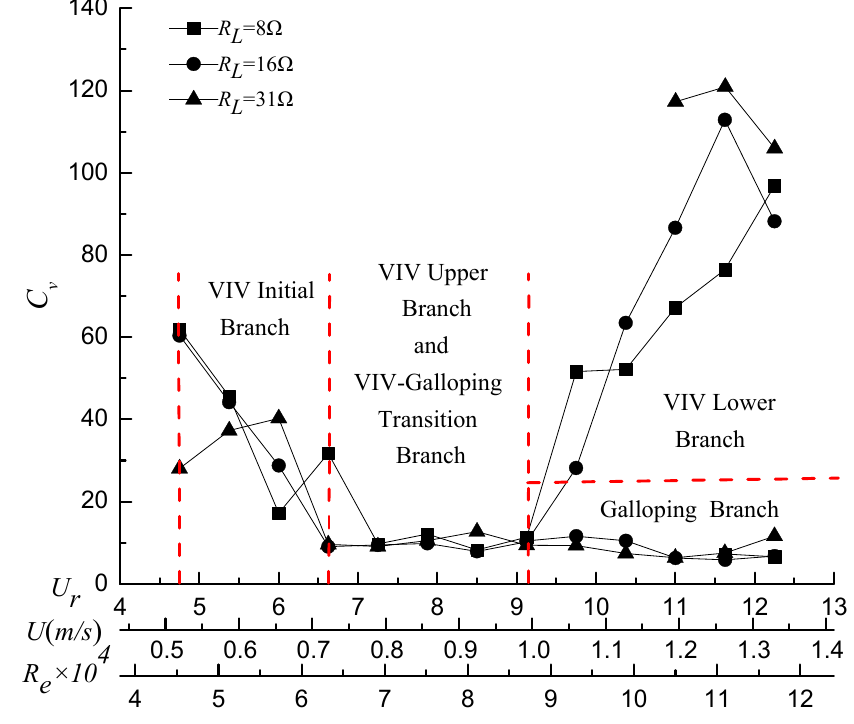
Figure 18. Power generation difference coefficient C v value.